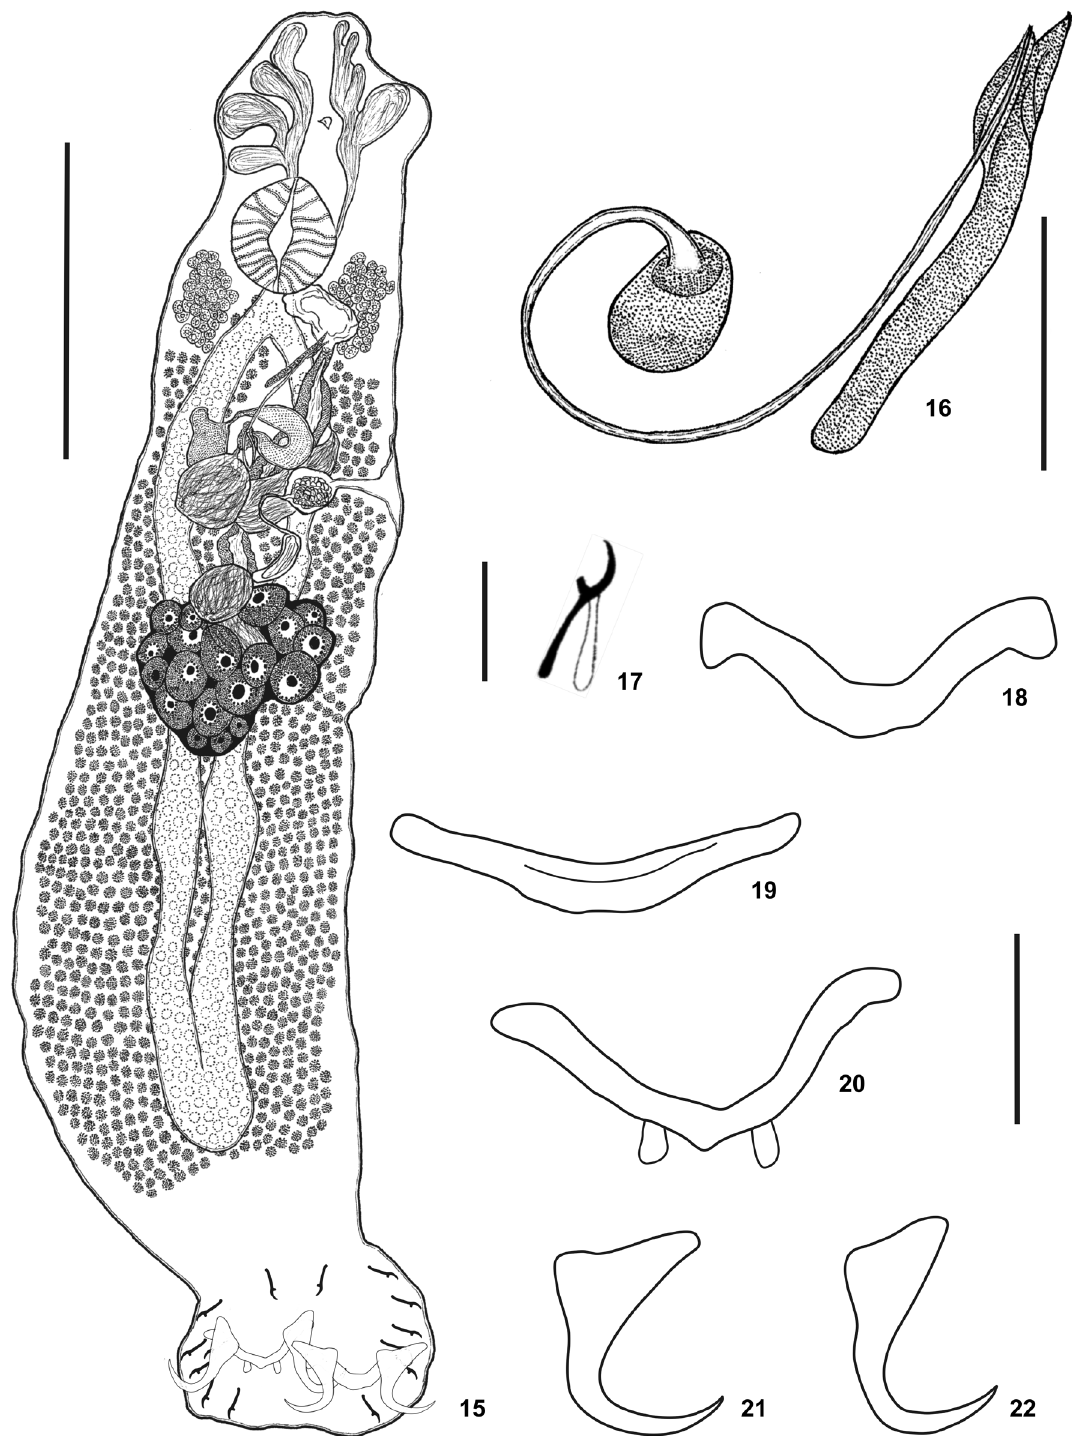
μm.Dactylogyrids Figures 15–22. Cosmetocleithrum akuanduba sp. nov.: (15) holotype whole-mount, ventral; (16) copulatory complex; (17) hook; (18–19) ventral bar; (20) dorsal bar; (21) ventral anchor; (22) dorsal anchor. Scale bars: 15 = 100 μm; 16, 18–22 = 25 μm; 17 = 10 ZOOLOGIA 35: e23917 | DOI: 10.3897/zoologia.35.e23917 | June 29,